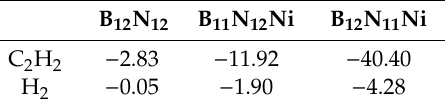
Table 2. The adsorption energies of C 2 H 2 and H 2 separately adsorb on B 12 N 12 , B 11 N 12 Ni and B 12 N 11 Ni (energies in kcal / mol).